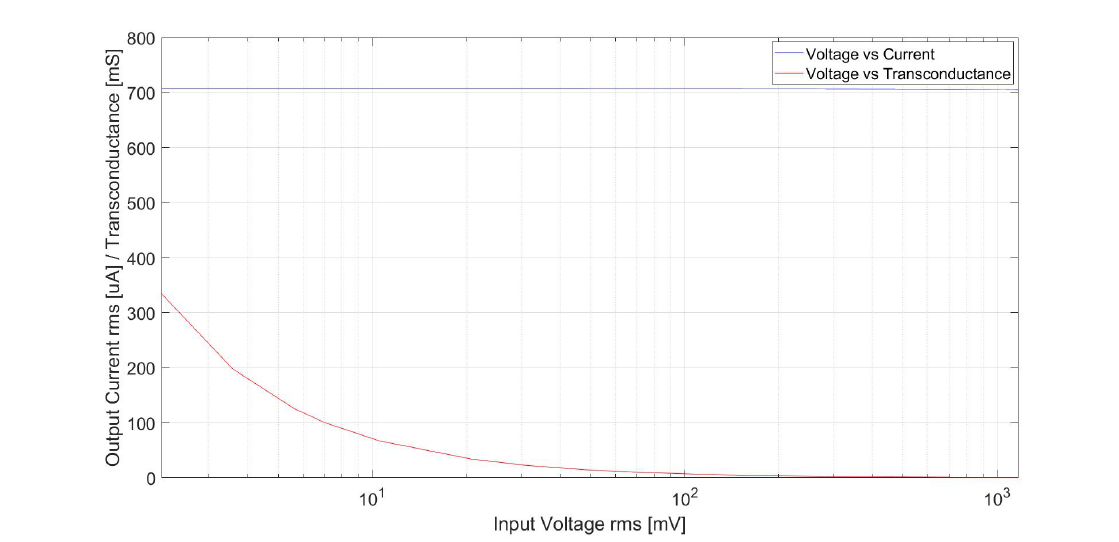
Figure 5. Results from the VCCS testing in a single frequency measurement system at 50 kHz. ( a ) The input voltage compensations due the impedances changes and ( b ) the transconductance changes of the implemented